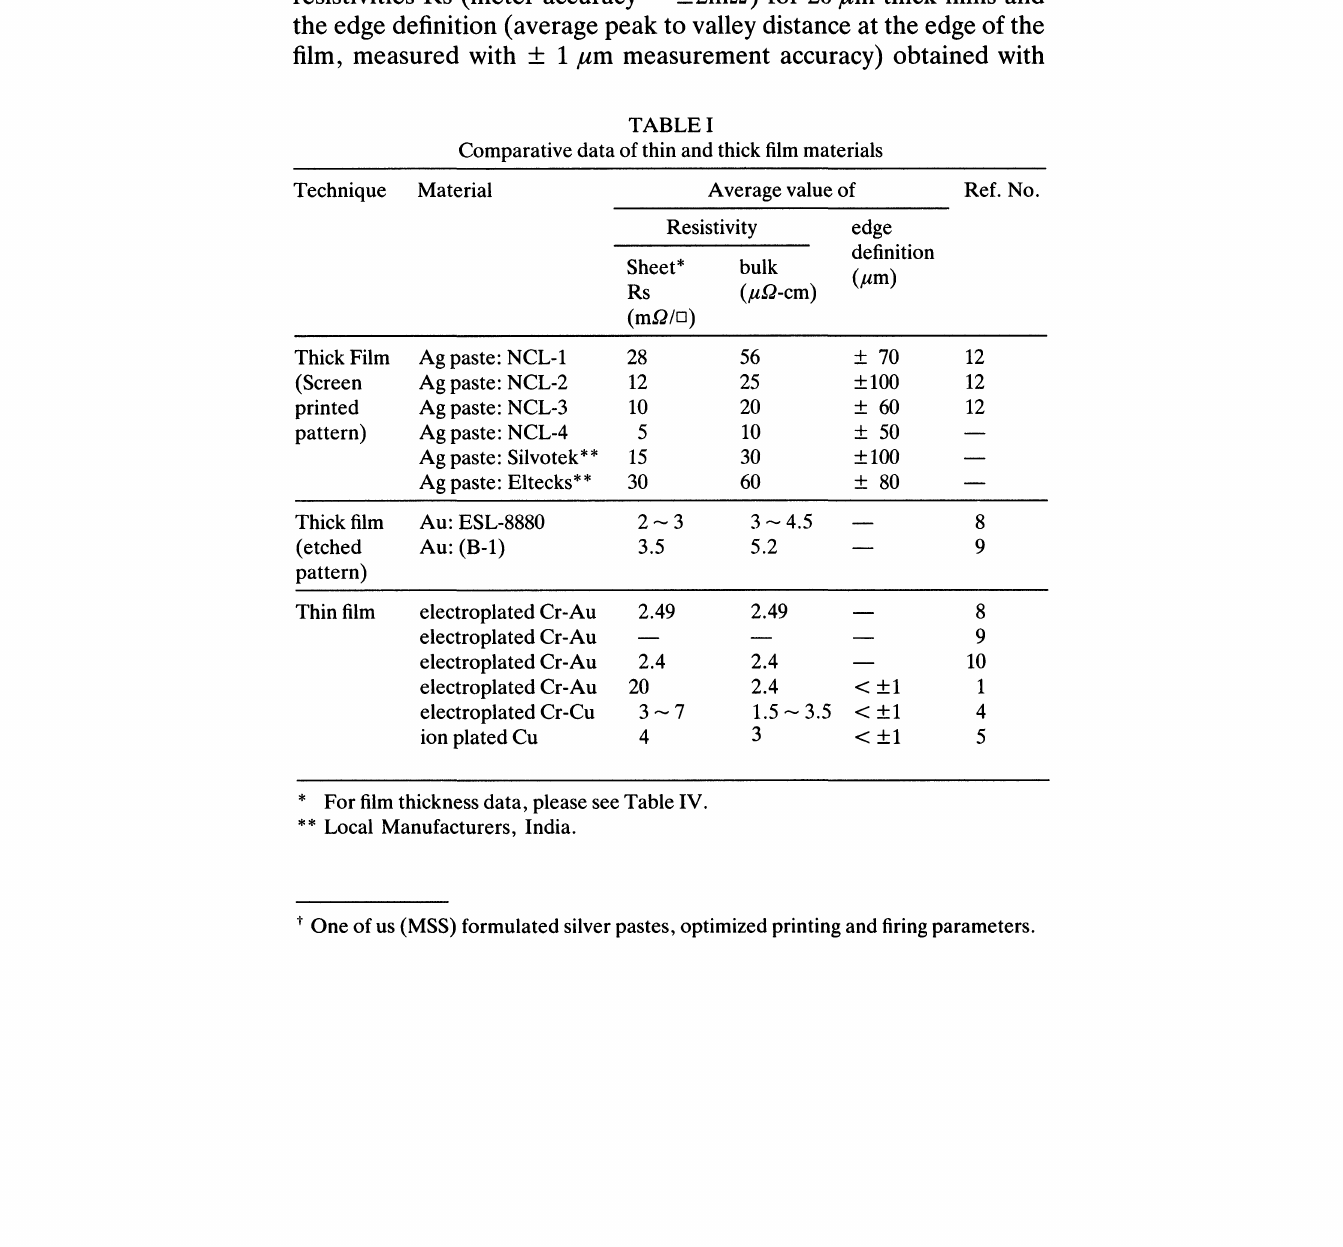
Comparative data of thin and thick film materials Technique